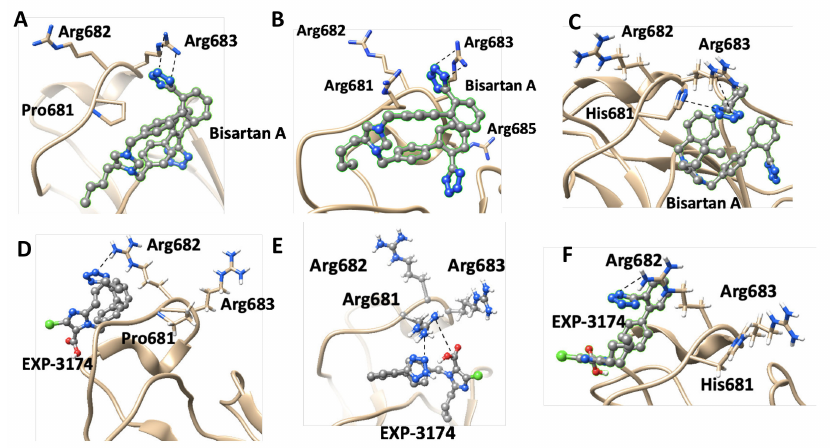
Figure 14. Upper panel: Closed view of docking pose of bisartan A in furin cleavage site of wild-type ACE2 ( A ), P681R ACE2 ( B ) and P681H ACE2 ( C ). Lower panel: closed view of docking pose of EXP-3174 in furin cleavage site of wild-type ACE2 ( D ), P681R ACE2 ( E ) and P681H ACE2 ( F ).